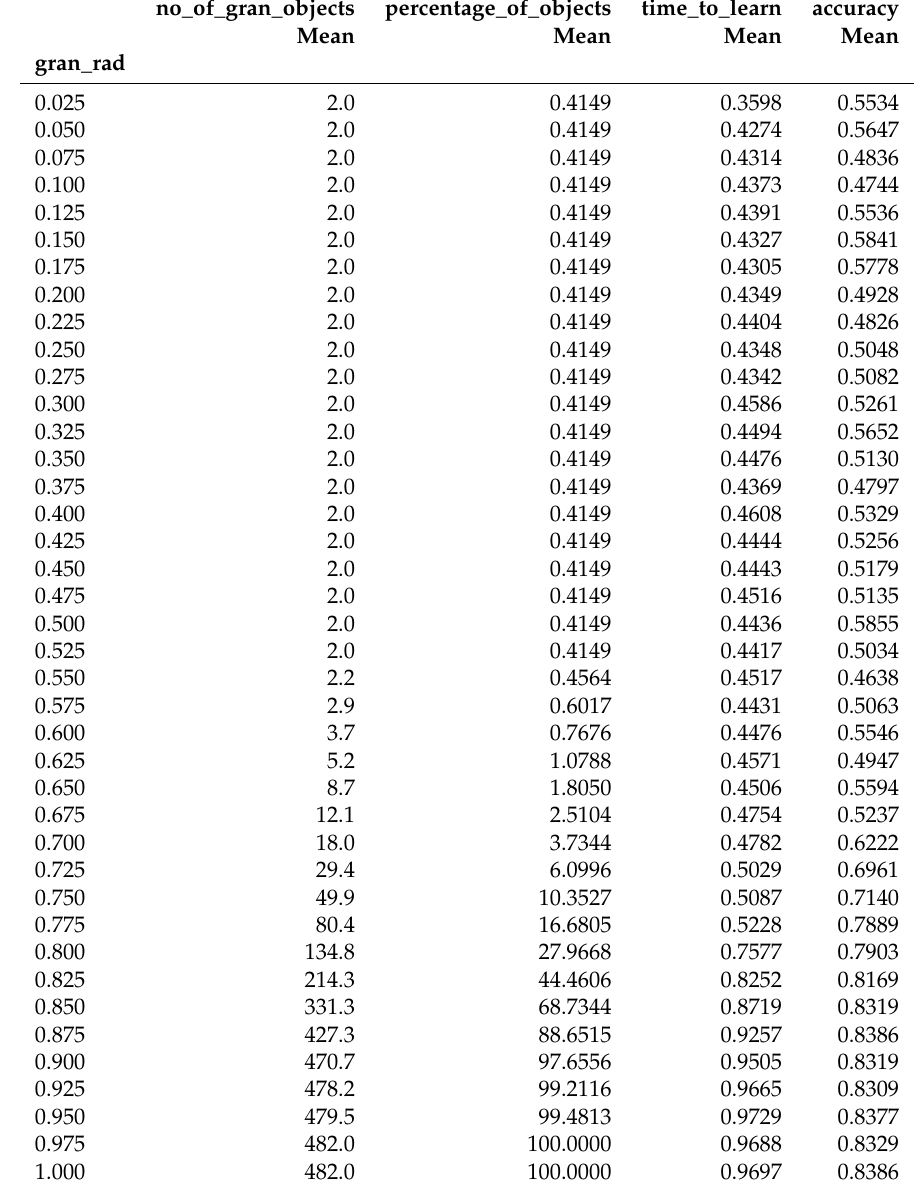
Table 8. Dummy variables—results for Australian credit dataset (mean from 10 experiments; after conversion to Dummy variables its 35